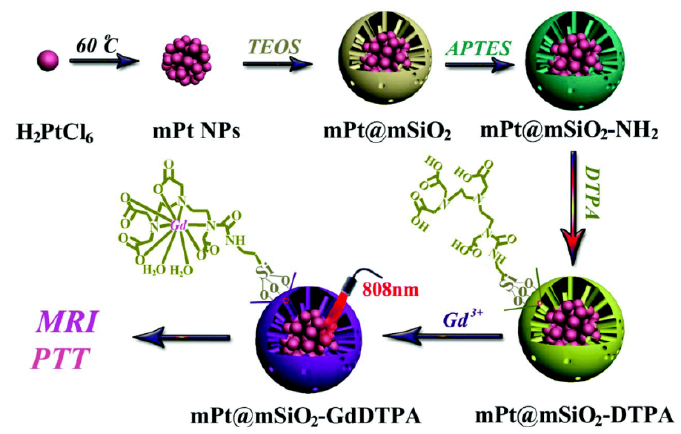
Figure 7. A core/shell hybrid based on a platinum core and MSN shell. Tethering with Gd-DTPA provides MRI activity with photothermal therapy mediated by the Pt core. APTES refers to (3-aminopropyl)triethoxysilane. Reprinted with permission from reference [111]. Copyright (2017) The Royal Society of Chemistry.